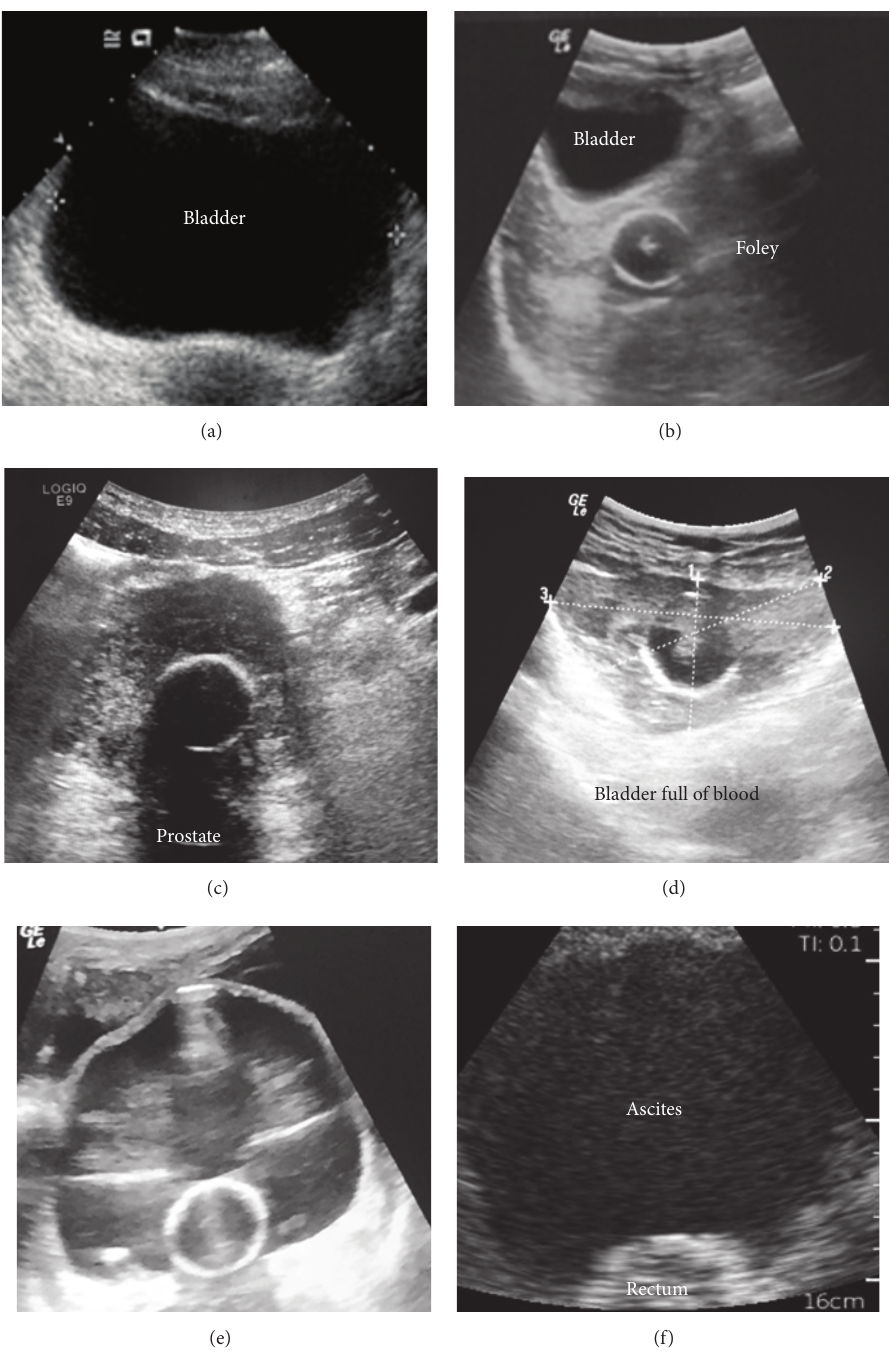
Figure 5: Postrenal assessment: bladder. (a) To calculate bladder volume, the maximum anterior-posterior bladder diameter is measured on an axis perpendicular to that of the longitudinal measurements. Volume (mL) = length (cm) × width (cm) × height (cm) × (0.52 to 0.57) for an ellipsoid (see Figure 4, probe position A). (b) shows a Foley bulb deployed in the pelvis of a patient with anuric renal failure. (c) shows a Foley bulb inflated in the prostate. (d) shows a Foley catheter positioned in a bladder filled with coagulated blood of an anuric patient. (e) Bladder is distended around the Foley bulb due to catheter obstruction. (f) Patient with ascites. Suprapubic view is sensitive for detecting pelvic fluid. It may be difficult to differentiate bladder fluid from ascites with